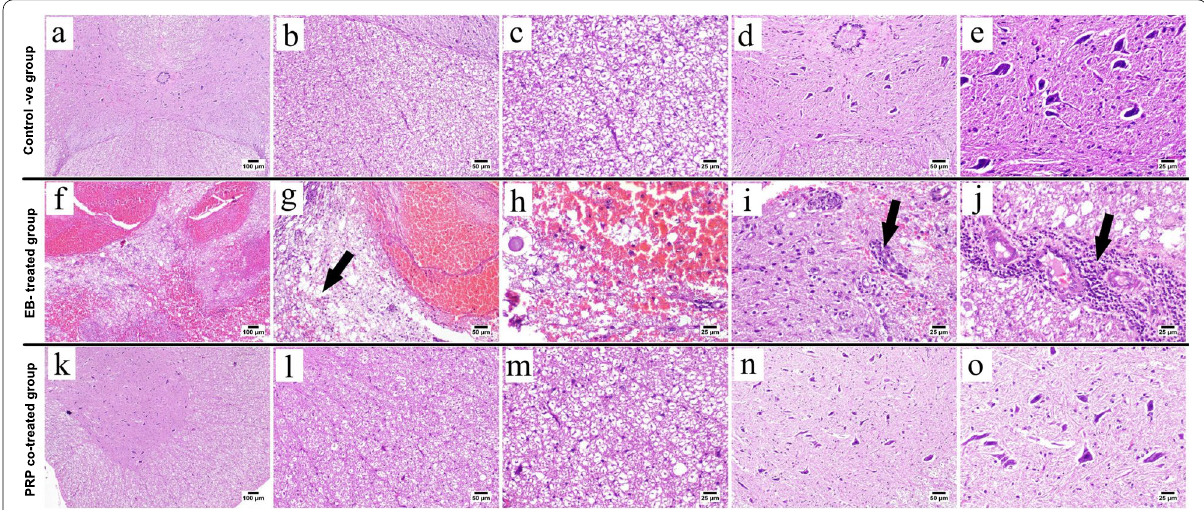
Fig. 6 Photomicrograph of H&E-stained spinal cord sections. a – e Control negative group showing normal histology of white matter ( b , c ) and gray matter ( d , e ). f – j EB-treated group showing f diffuse hemorrhage in the spinal cord; g hemorrhage with marked demyelination (arrow); h higher magnification, hemorrhage with vacuolated areas of demyelination; i gliosis (arrow); j marked perivascular lymphocytic infiltration. k – o PRP co-treated group showing k apparently normal spinal cord, l , m apparently normal white matter, and n , o apparently normal gray